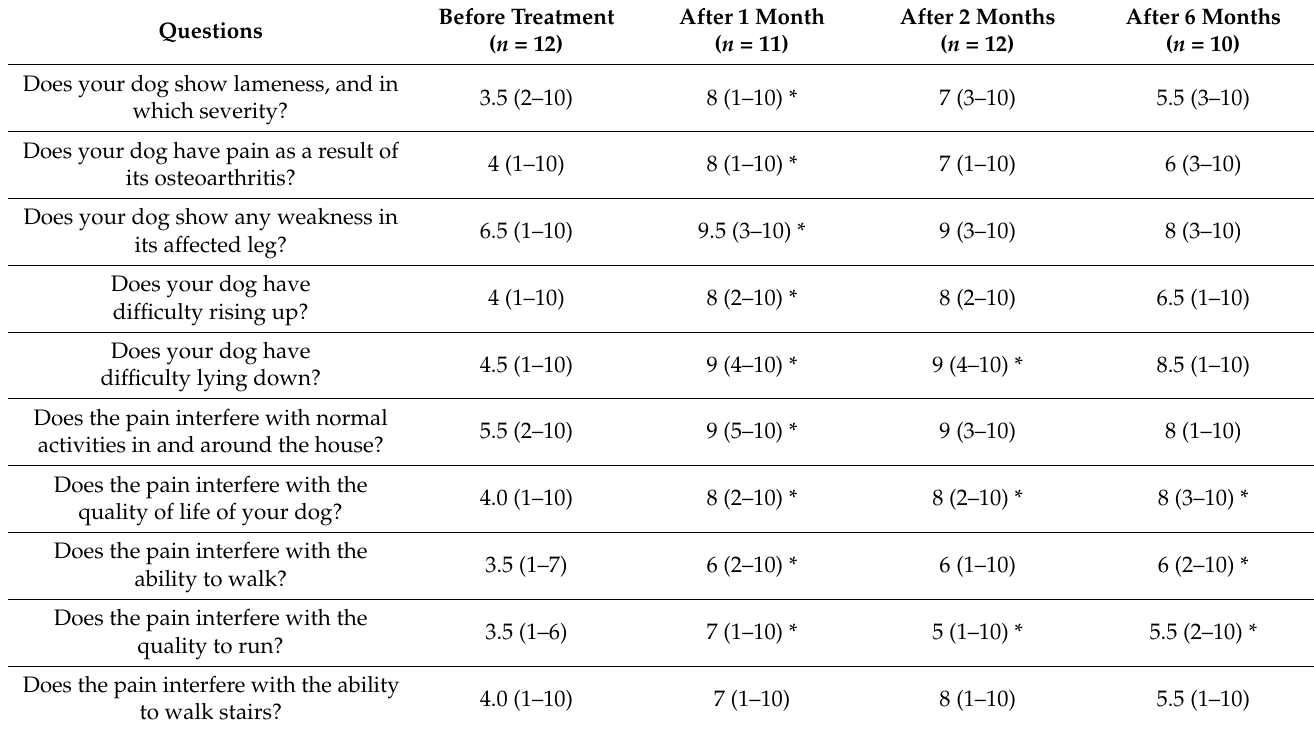
Table 1. Responses to owners’ questionnaires before and one, two and six months after intra-articular injection with triamcinolone acetonide-loaded